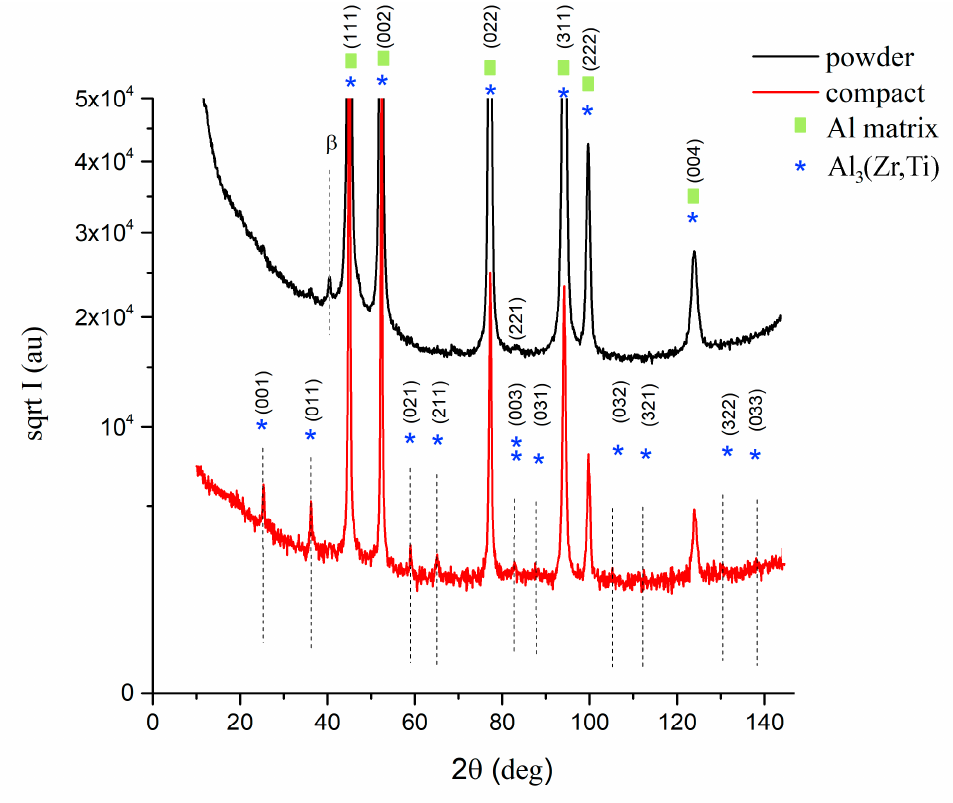
Figure 2. XRD di ff ractogram of mechanically milled powder and its sintered Figure 2. XRD diffractogram of mechanically milled powder and its sintered compact.